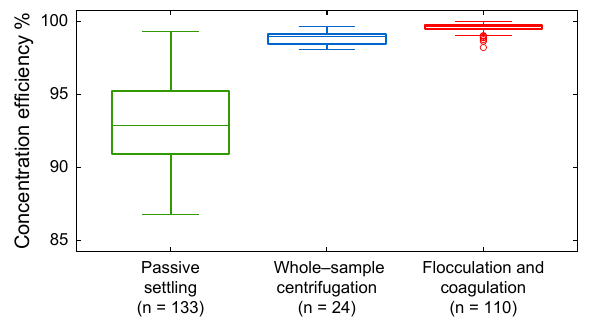
Figure 3. Box plot of the concentration efficiency (%) of three dif- ferent methods for particle concentration of mesocosm sediment trap samples. Concentration of particles by passive settling (green) is compared with gravitational deposition of particulates by whole- sample centrifugation (blue). The third option of flocculation and coagulation with FeCl 3 for enhanced particle settling is presented in red. Concentration efficiency is defined as the percentage of TPC concentrated in the processed sediment trap samples in relation to the particulate carbon in the originally sampled suspensions (sum of concentrated and residual TPC in the bulk water). Outliers (circles) are defined as any data points below 1.5 × IQR (interquartile range) of the first quartile hinge or above 1.5 × IQR of the third quartile